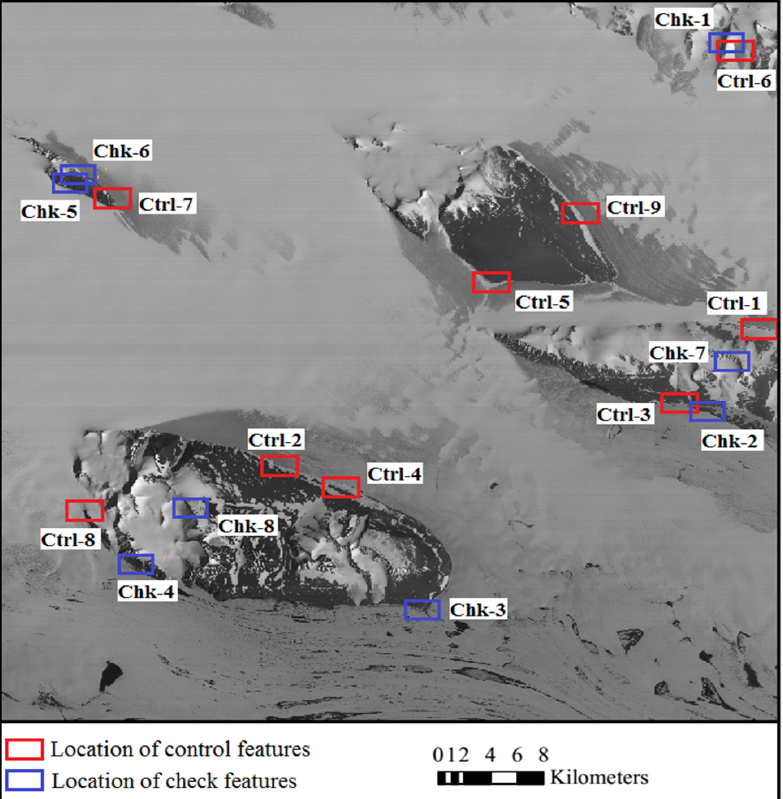
Figure 5. Distribution of the control features and the check features for the ASTER images.